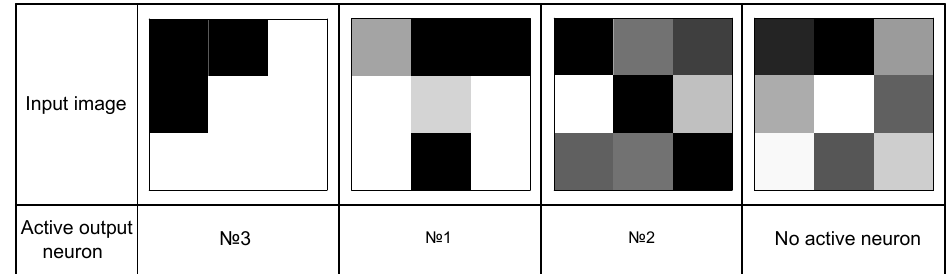
Figure 11. Examples of image classification of distorted patterns indicating activated output neurons.